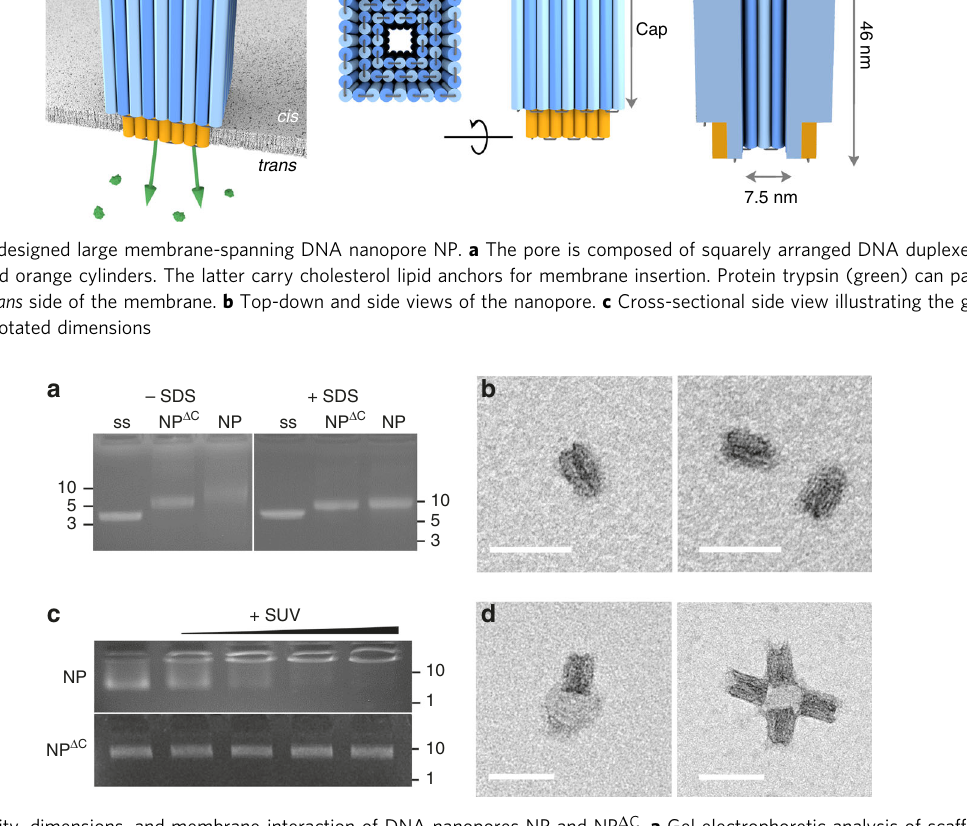
Fig. 2 Assembly, purity, dimensions, and membrane-interaction of DNA nanopores NP and NP Δ C . a Gel electrophoretic analysis of scaffold strand (ss), nanopores NP Δ C and NP without and with detergent SDS, respectively. The position and kilo base pair length of the dsDNA markers are annotated at the sides of the electropherograms. b Representative transmission electron microscopy (TEM) images of negatively stained NP Δ C . Scale bar, 50 nm. c Gel electropherogram of NP and NP Δ C incubated with no (leftmost lane) or increasing amounts of small unilamellar vesicles (SUVs) ranging in concentrations from 6.9 to 12.5 nM. The upshifted bands of lipid anchor-bearing NP indicate favourable interactions with bilayer membranes. The interaction does not occur for anchor-free NP Δ C . The position of the two dsDNA markers with a length of 10 and 1 kbp is given at the right of the gels. d Representative TEM images of negatively stained NP inserted into SUVs. Scale bar, 50 nm. Source data are provided as a Source Data fi